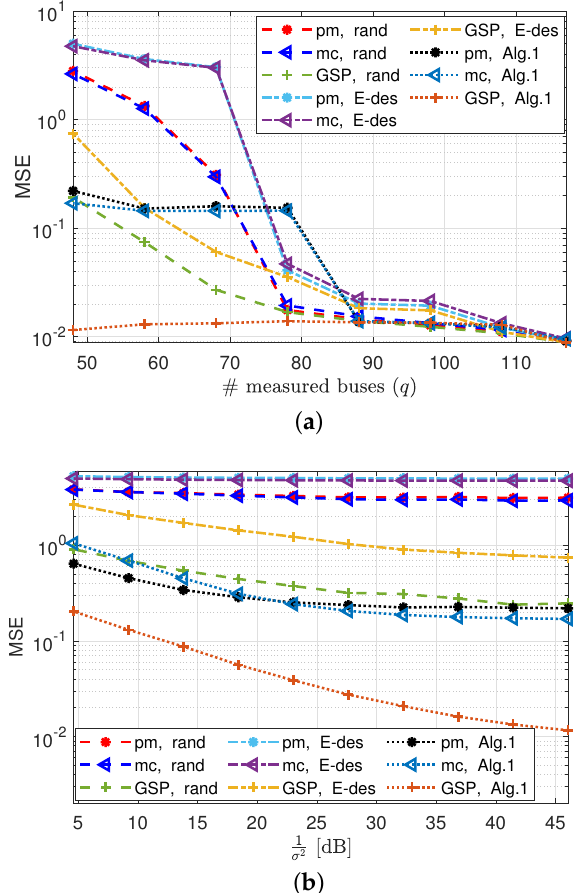
Figure 7. State estimation under the DC − PF model: the MSE of the GSP − WLS from (26) and (27), pm − WLS [11], and mc [5] estimators for random, E − design [38], and Algorithm 1 bus selection policies versus ( a ) the number of buses, q , with σ 2 = 0.01, and ( b ) 1